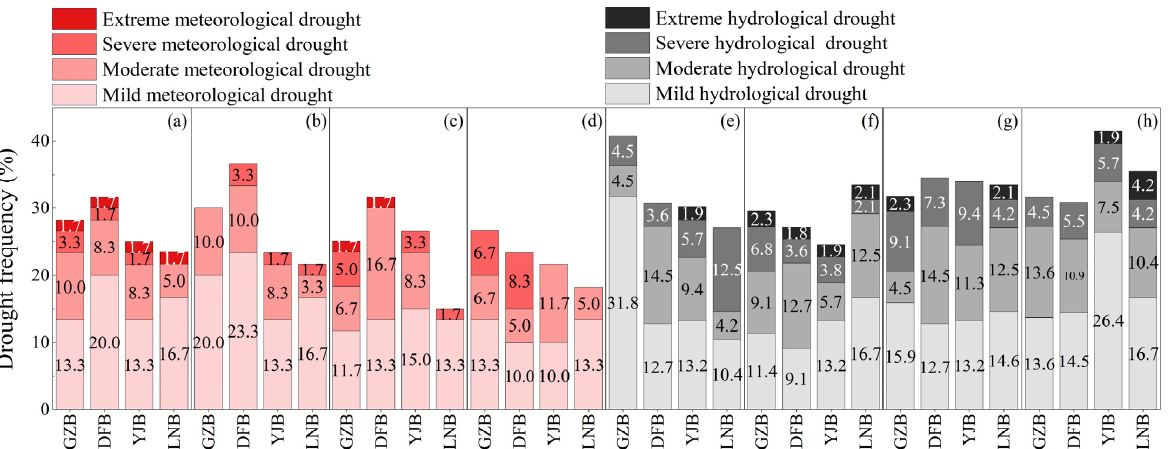
Figure 3. Drought frequency in different seasons in the YLB from 1960 to 2019; ( a – d ) indicate mete- orological drought, while ( e – h ) indicate hydrological drought; spring ( a , e ), summer ( b , f ), autumn ( c , g ), and winter ( d , h ).